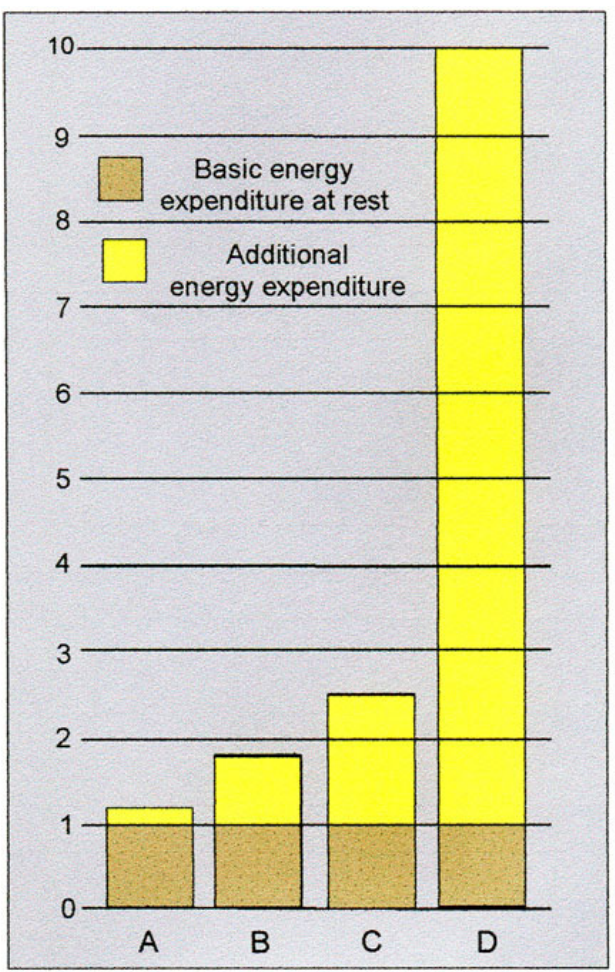
Figure 2: Relative increase of energy expenditure by red deer moving on snow-free and snow-covered ground at different speeds (modified from Esslinger 1988). A – Standing, B – Walking (1 km on level snow-free ground), C – Browsing when walking on snow-covered ground, D – Fleeing on snow-covered